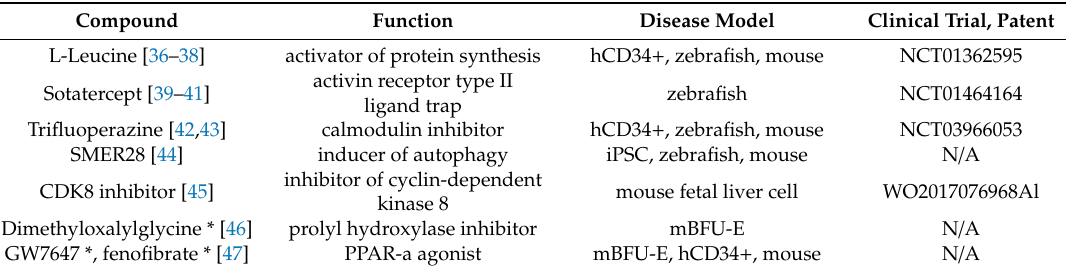
Figure 2. Zebrafish in vivo phenotype screening. Zebrafish provides a novel platform for screening compound libraries and evaluating drug e ffi cacy in vivo, which will lead to find new therapeutics for rare diseases including DBA. Table 2. Drug candidates for